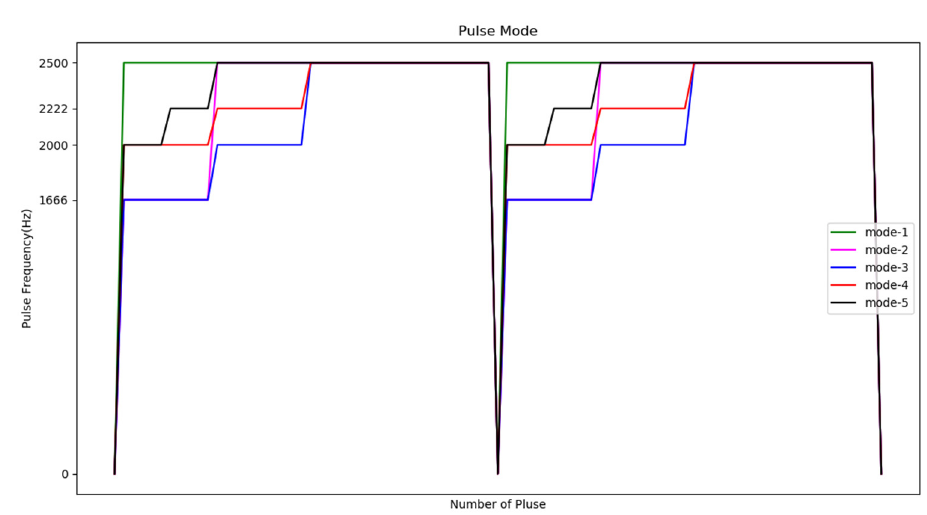
Figure 22. Time distribution diagram of pulse frequency.